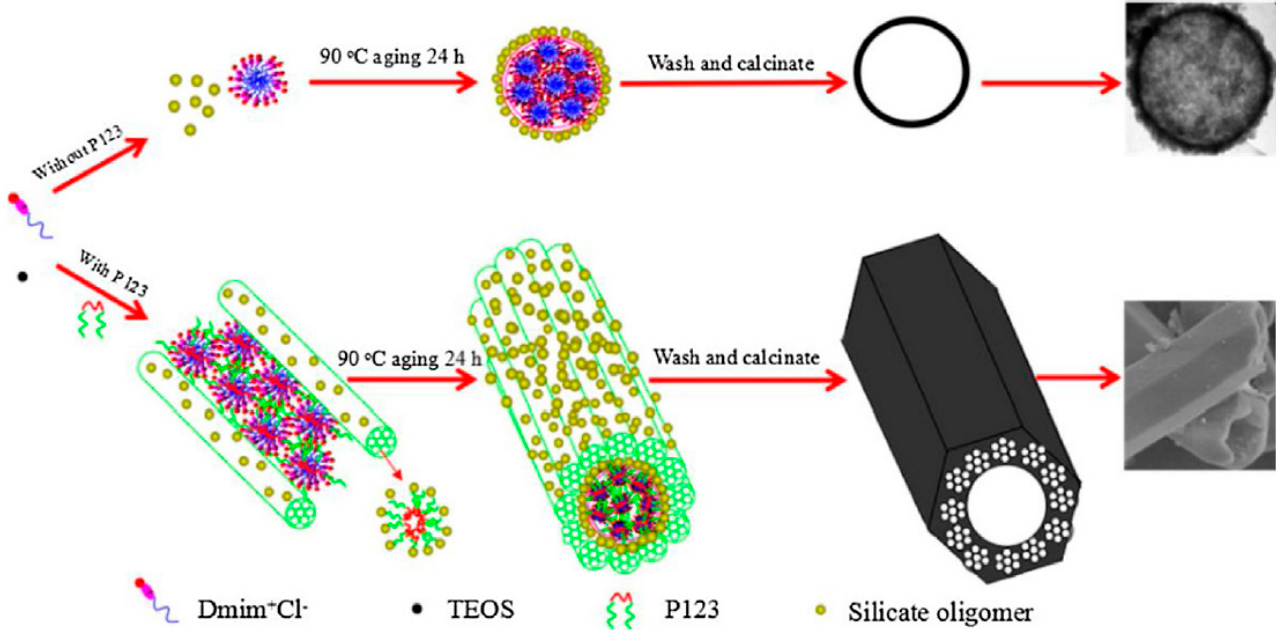
Figure 11. Schematic representation of the effects of C ₁₀ C ₁ ImCl and ionic liquid-based surfactant plus the co-template (P123) on the morphology of the formed SiO 2 NPs. HCl is used to hydrolyze tetraethyl orthosilicate silane (TEOS), the silicate precursor [195]. Reprinted with permission from ref. [195]. Copright 2021 Elsevier.